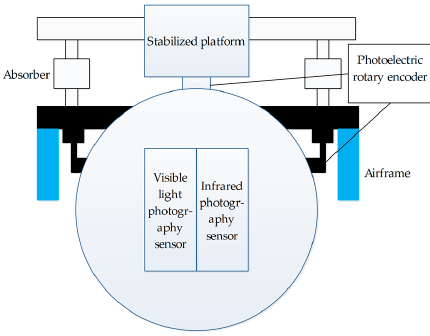
Figure 2. Structure chart of the onboard optoelectronic platform.